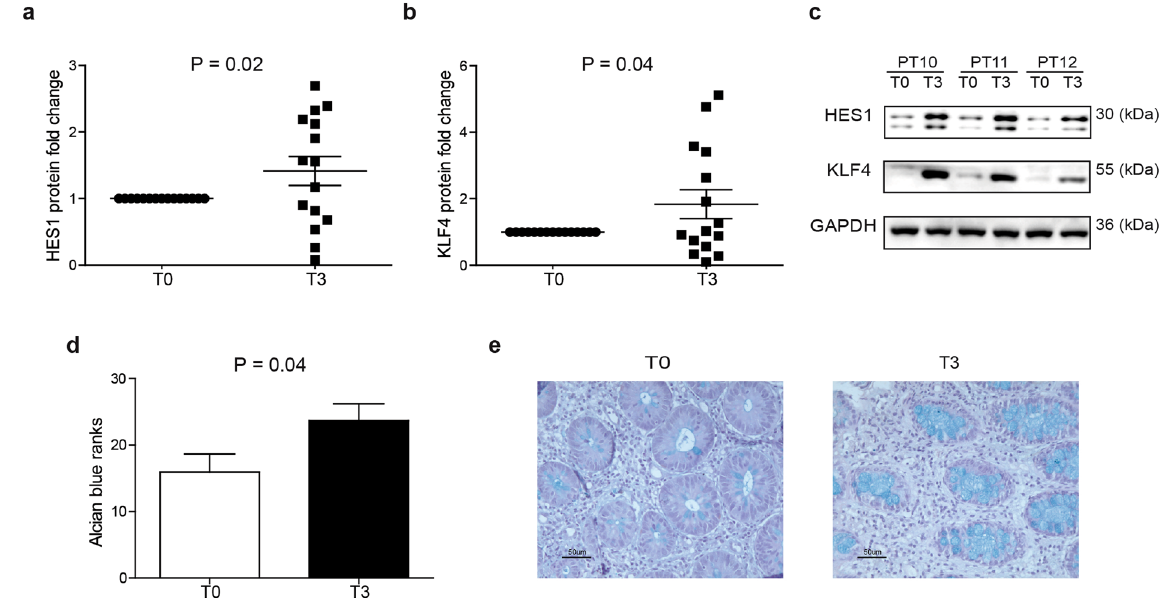
Figure 4. Protein expression levels of (a) HES1 and (b) KLF4 on homogenized sigmoid colon tissues in compliant and responder patients (n = 15) at T0 and T3. Statistical significance was measured using one- sample two-tailed t-test. Data are shown as mean of square root transformed values ± SEM. (c) Western blot representative images of HES1 and KLF4 at T0 and T3 (n = 3). (d) Alcian blue ranks and (e) representative images of goblet cells staining at T0 (left panel) and T3 (right panel). Statistical significance for Alcian blue ranks was calculated using the paired two-tailed t-test. Data are shown as mean of ranks ±